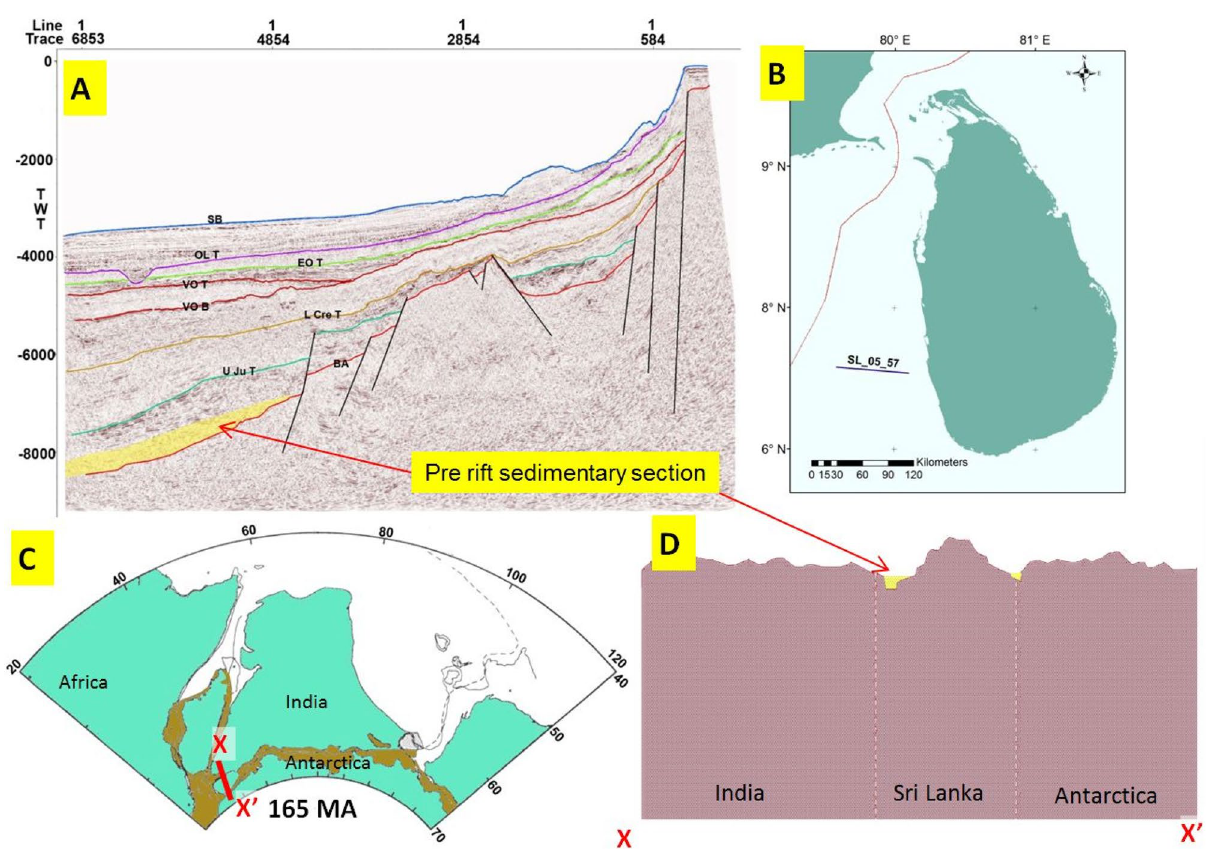
Fig. 5 a Seismic line SL-05-57 depicting the pre-rift sediments above the horizon BA (Basement Top). b Base map showing the location of the line SL-05-57. c Plate tectonic reconstruction at 165 Ma. Seafloor spreading has begun between East and West Gondwana and off